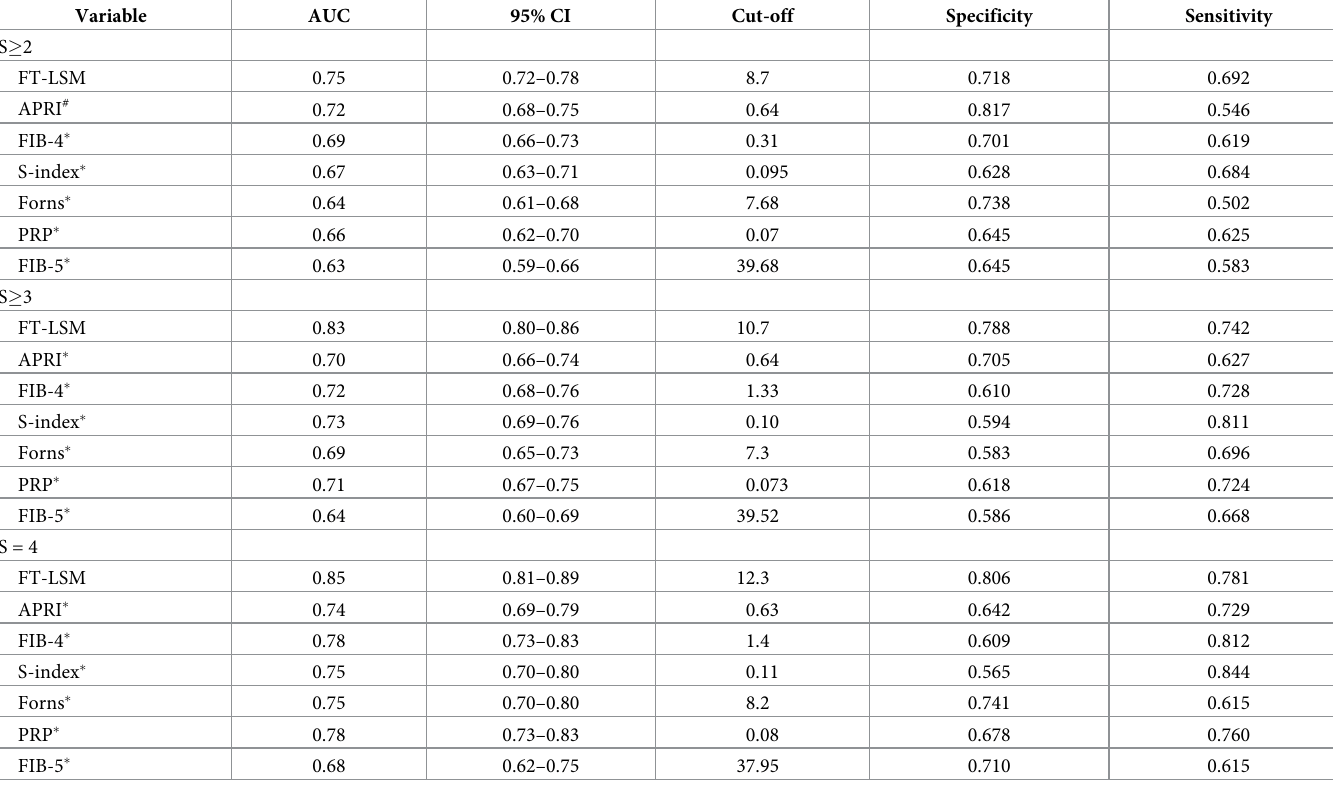
Table 3. The diagnostic value of FibroTouch and six serological models to fibrosis S � 2, S � 3 and S = 4. Variable